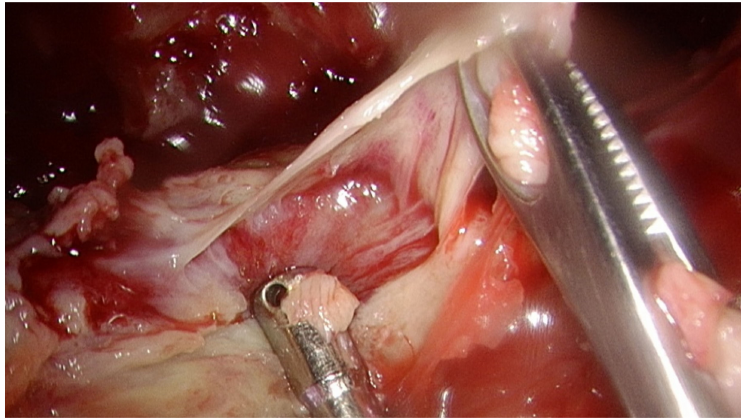
Figure 1. The pleural peels tissue culture in a patient with stage II